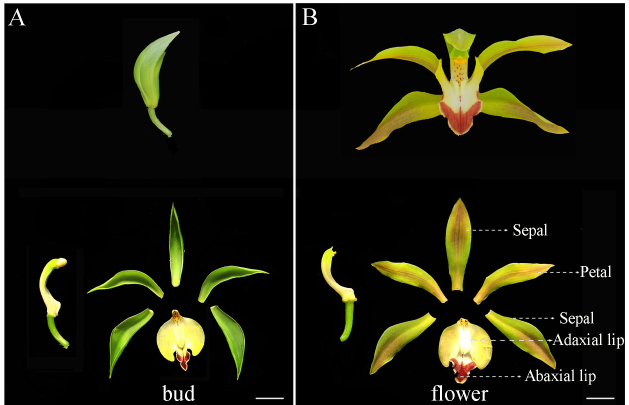
Figure 1. Two stages of C. lowianum flower development: ( A ) bud and ( B ) flower. V-shaped red abaxial, and adaxial of lip, petal, and sepal of bud and flower were collected as samples for this study. Bar = 0.5